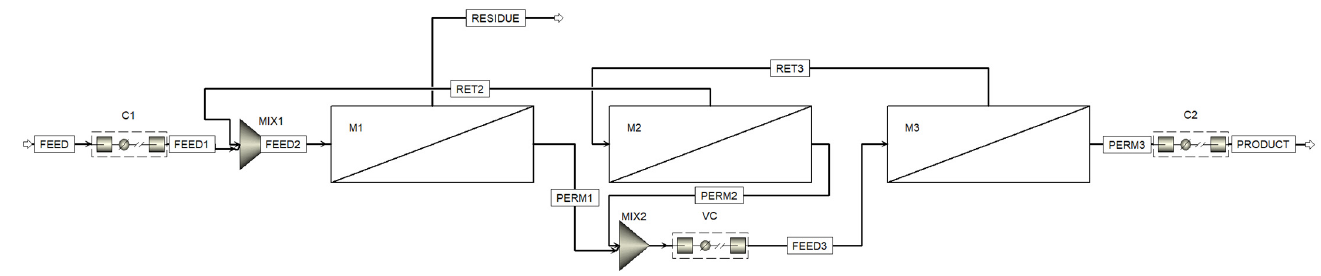
Figure 3. The process flow diagram designed in the Aspen™ Plus. M1, M2, and M3—membrane units; C1 and C2—compressors; VC—vacuum compressor.